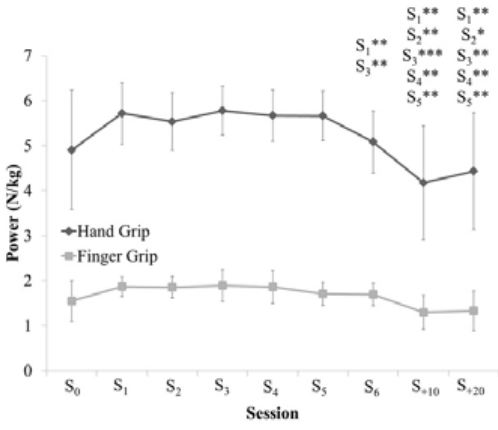
Figure 4. Hand- and finger-grip strength recorded after each badminton session. Values are mean and standard deviation. A significant difference at the post hoc test with S 0 is indicated by *: P < 0.05; **: P < 0.01; ***: P <